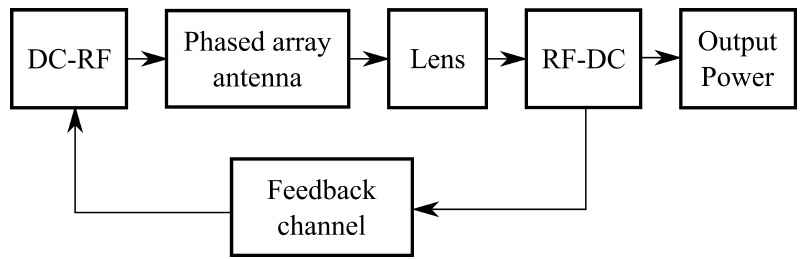
Figure 1. System